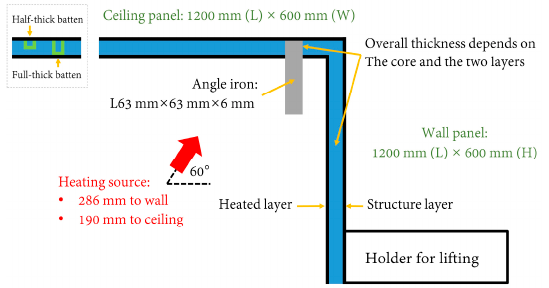
Figure 1. Common shapes and dimensions of specimens (side view).